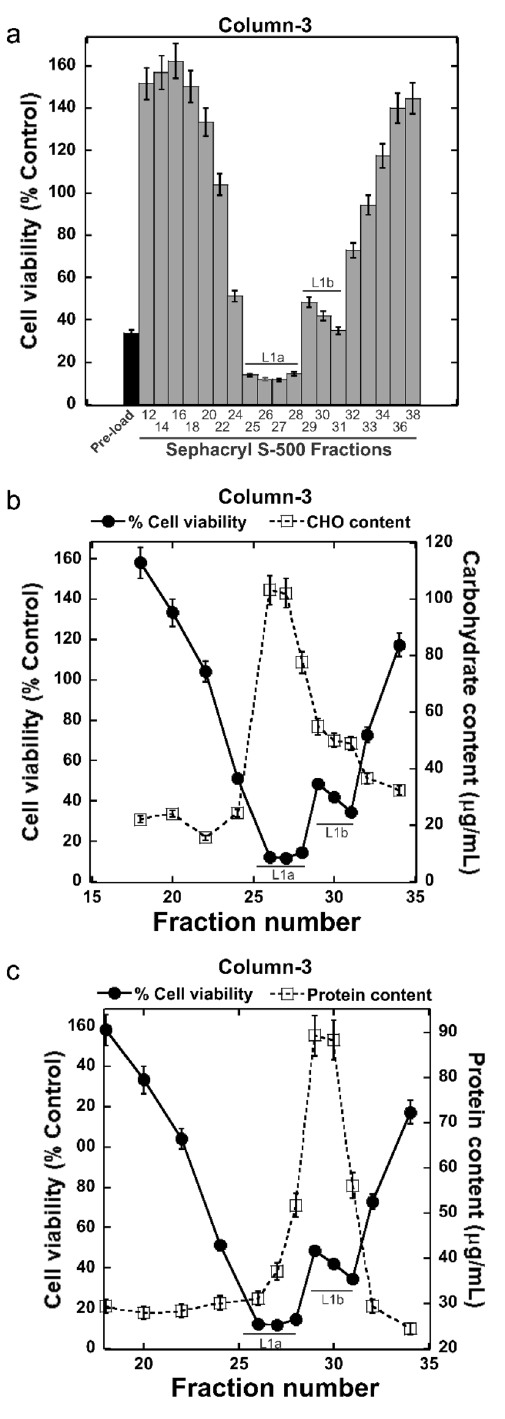
Figure 2. Purification of the anti-proliferative polysaccharide from E. tinctorium (EtGIPL1a) using Sephacryl S-500 (column-3). Collected fractions were assessed for cell viability ( a ), carbohydrate ( b ) and protein content ( c ). Error bars represent S.D. and results are representative from three separate